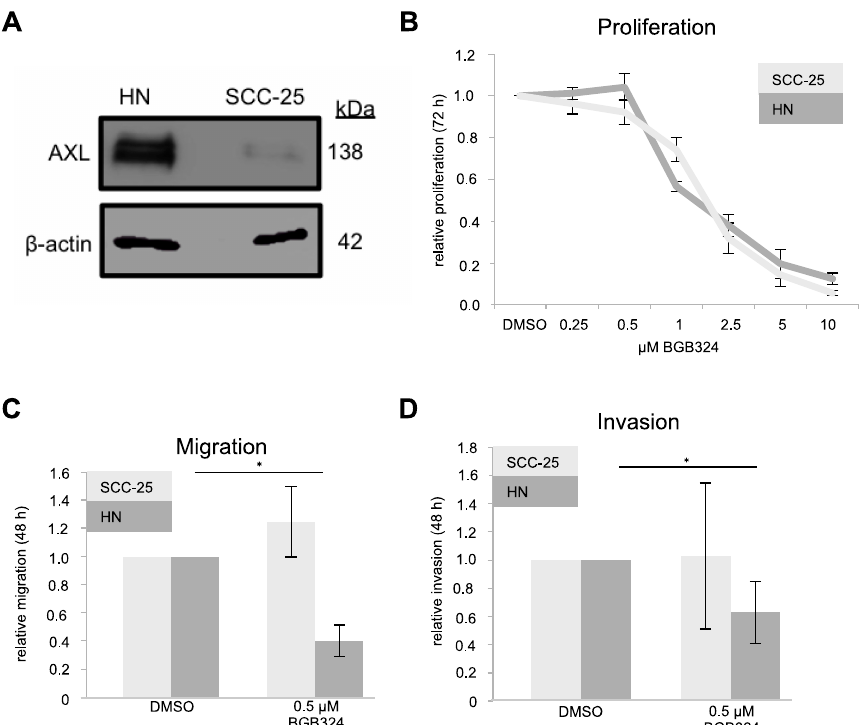
Figure 3. AXL inhibition with BGB324. ( A ) AXL expression in HN and SCC-25 cells; ( B ) relative proliferation of AXL high HN cells and AXL low SCC-25 cells after treatment with different amounts of BGB324 ( n = 3, each in triplicates); ( C ) relative migration of AXL high HN cells and AXL low SCC-25 cells after pre-treatment with 0.5 µM BGB324 for 24 h ( n = 4); and ( D ) relative invasion of AXL high HN cells and AXL low SCC-25 cells after pre-treatment with 0.5 µM BGB324 for 24 h ( n = 4). ( C , D ) two-tailed paired t -test, n = 3, * p < 0.05). DMSO, Dimethyl sulfoxide.